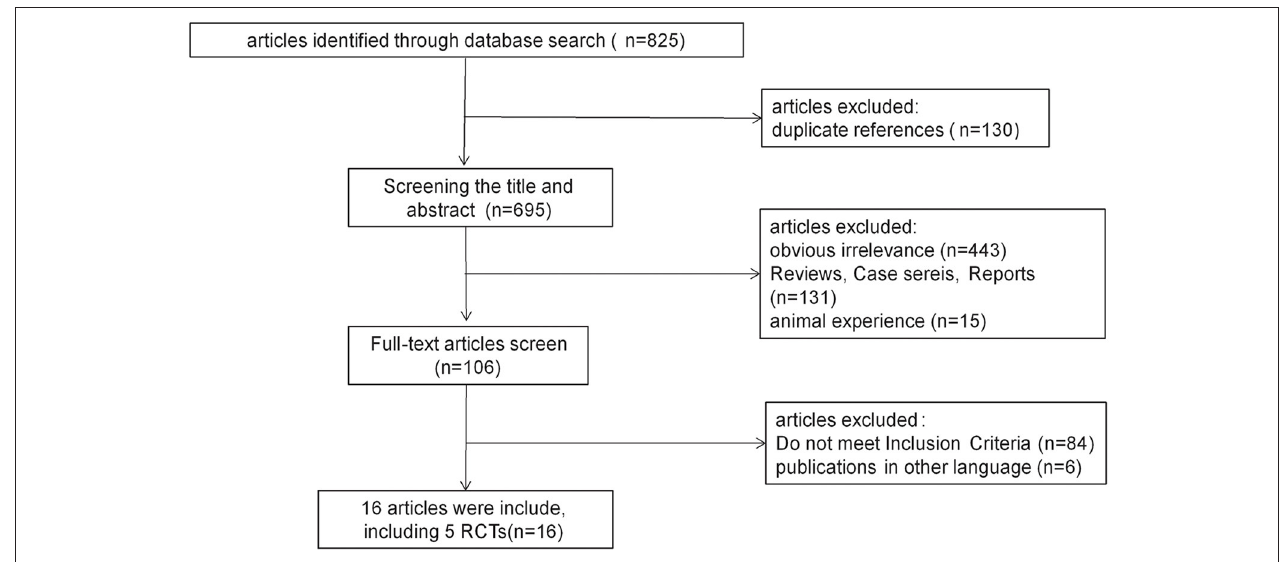
FIGURE 1 | Flow diagram of study selection